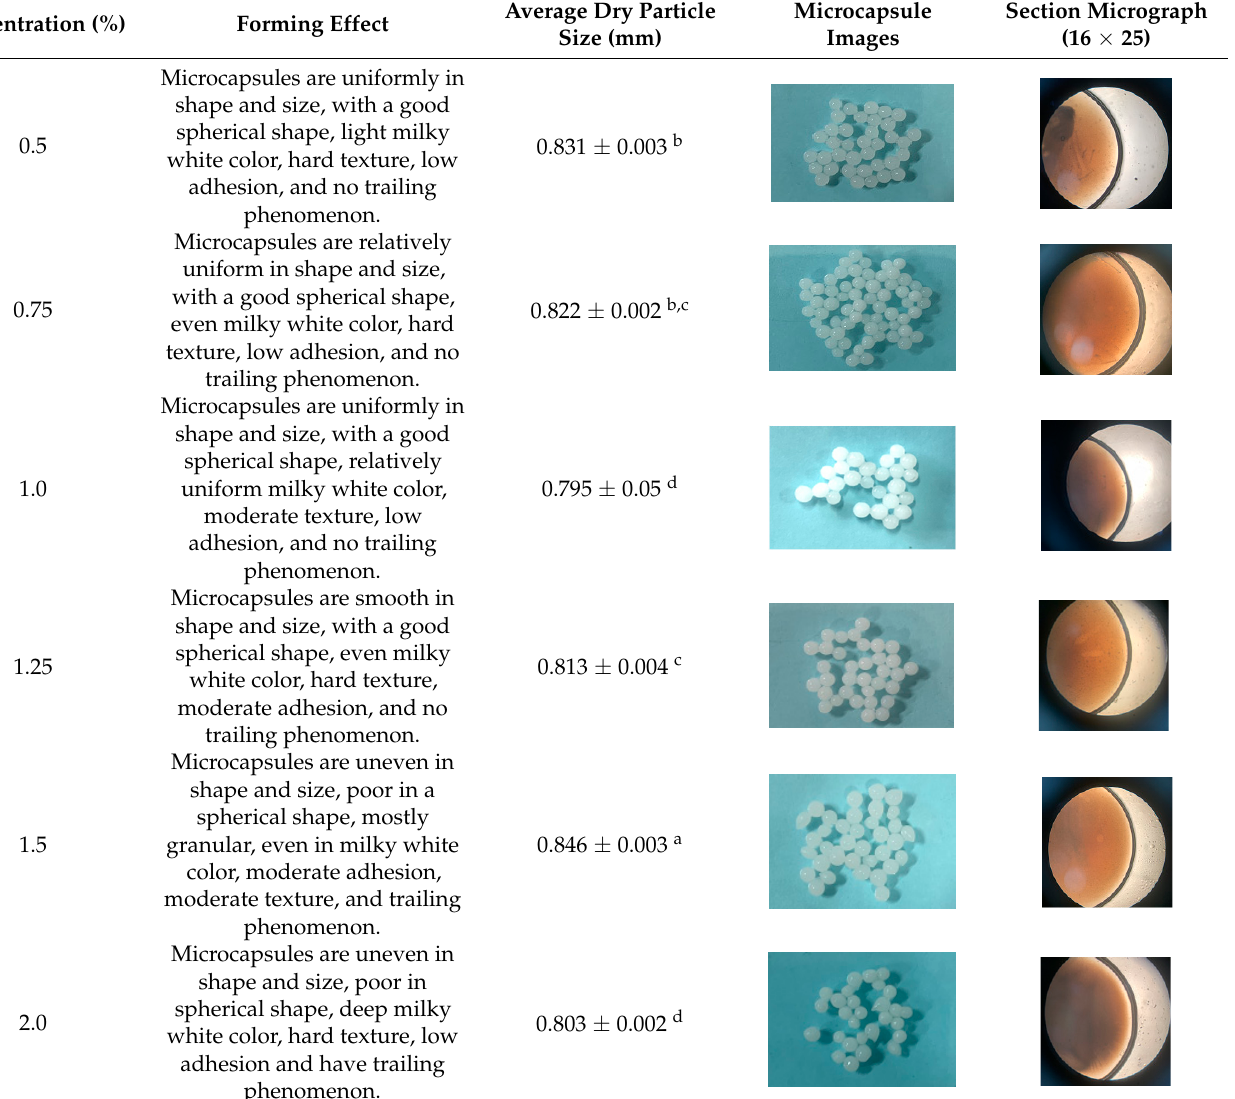
form in shape and size, with a good spherical shape, even milky white color, hard texture, low adhesion, Microcapsules are uniformly in shape and size, with a good spheri- cal shape, relatively uniform milky white color, moderate texture, low